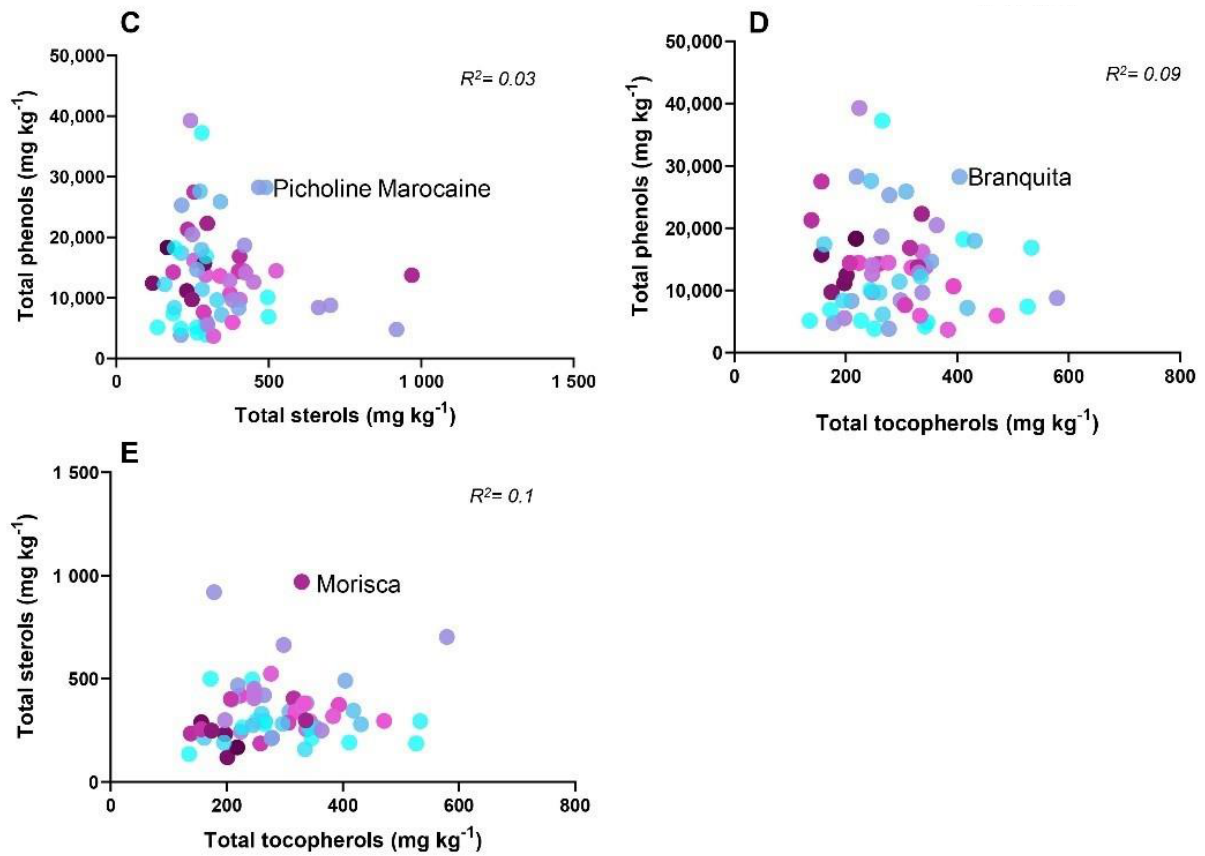
Figure 5. Scatter plot showing multiple regressions among the main traits (total phenols, total tocopherols, total sterols, squalene, and OCFFW). Data are expressed as mg kg − 1 of fruit pulp. Violet circles indicate high content of OCFFW, and light blue circles indicate low content of OCFFW.